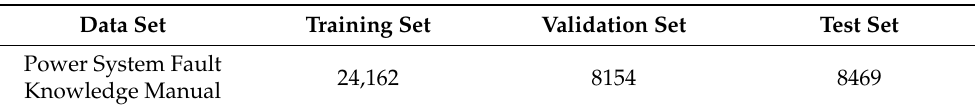
Table 5. Specific size of data set for entity